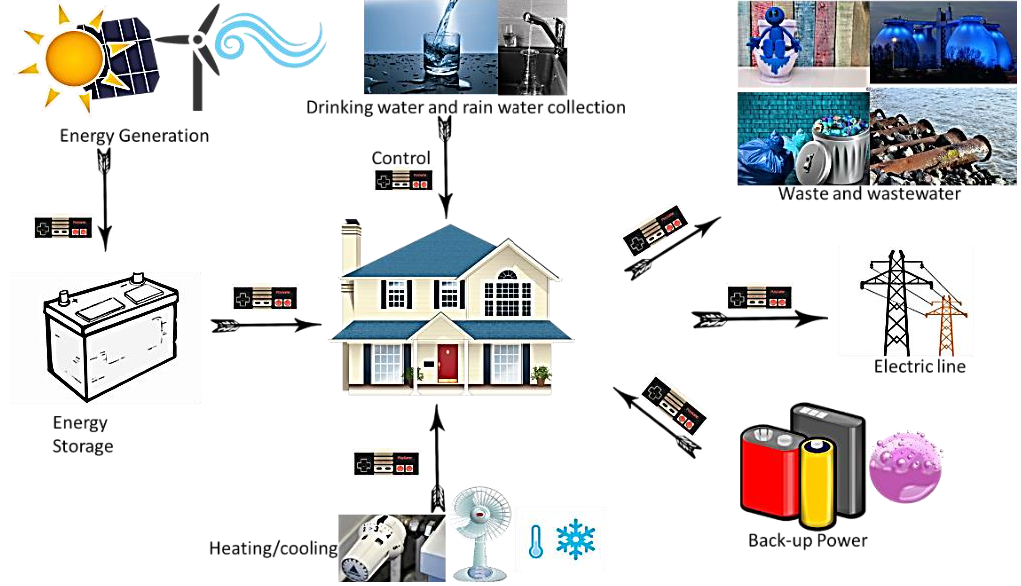
Figure 5. Setup for a nano-grid house.